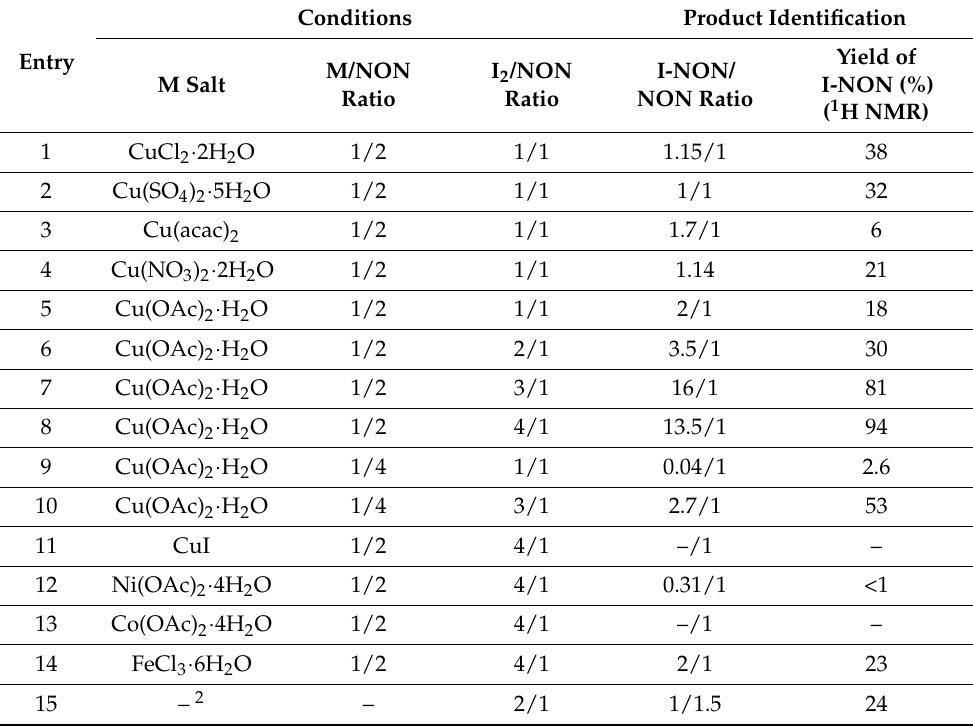
Table 1. Optimization of the reaction conditions. 1 . Conditions Product Identification Entry M